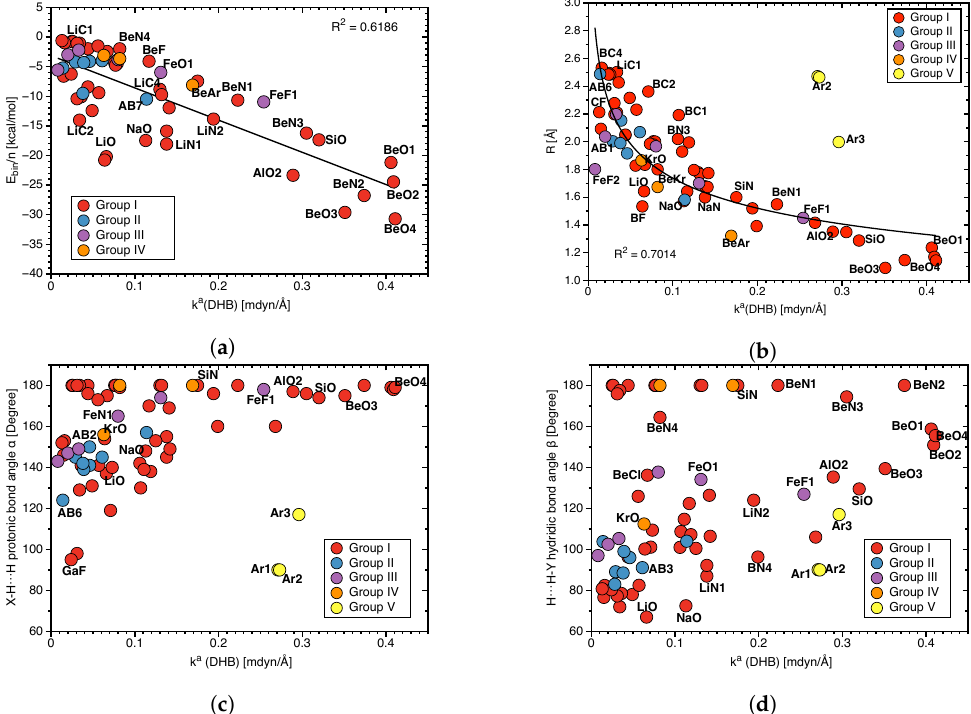
Figure 4. ( a ) Correlation between binding energy E bin scaled by the number of DHBs n and k a (DHB), ( b ) correlation between distance R(DHB) and k a (DHB), ( c ) correlation between protonic bond angle (X–H δ + · · · H δ − ) and k a (DHB), ( d ) correlation between hydridic bond angle (H δ + · · · H δ − –Y) and k a